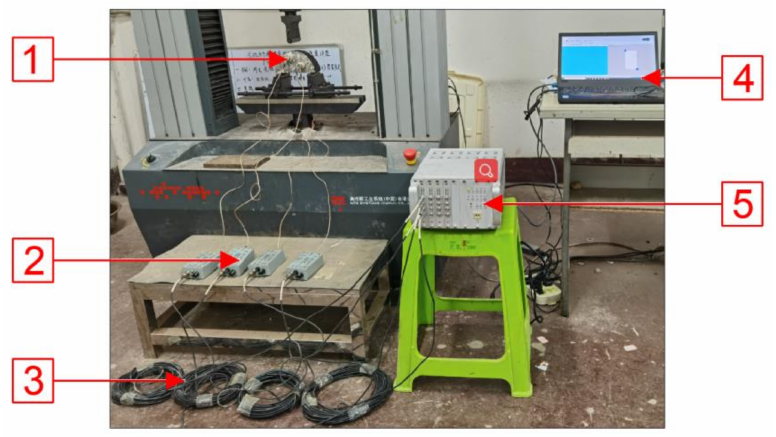
Figure 4. AE test system: 1: G8 sensors; 2: Preamplifier; 3: Cable; 4: Computer; 5: High-speed digital AE detector.